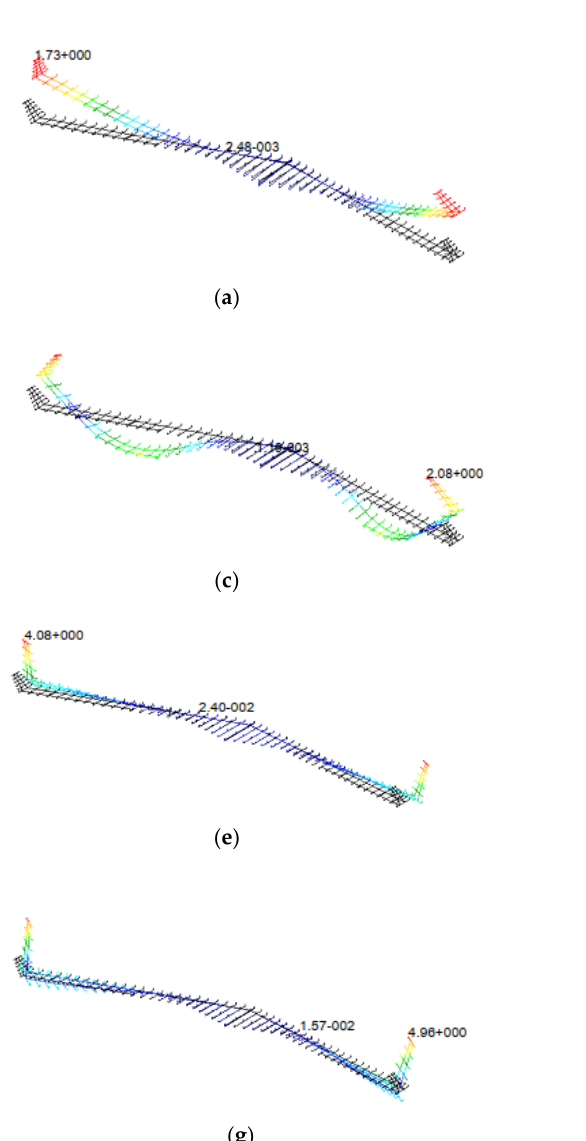
10 of 20 Figure 2. Aircraft FEM model. Table 1. Design parameters. Item